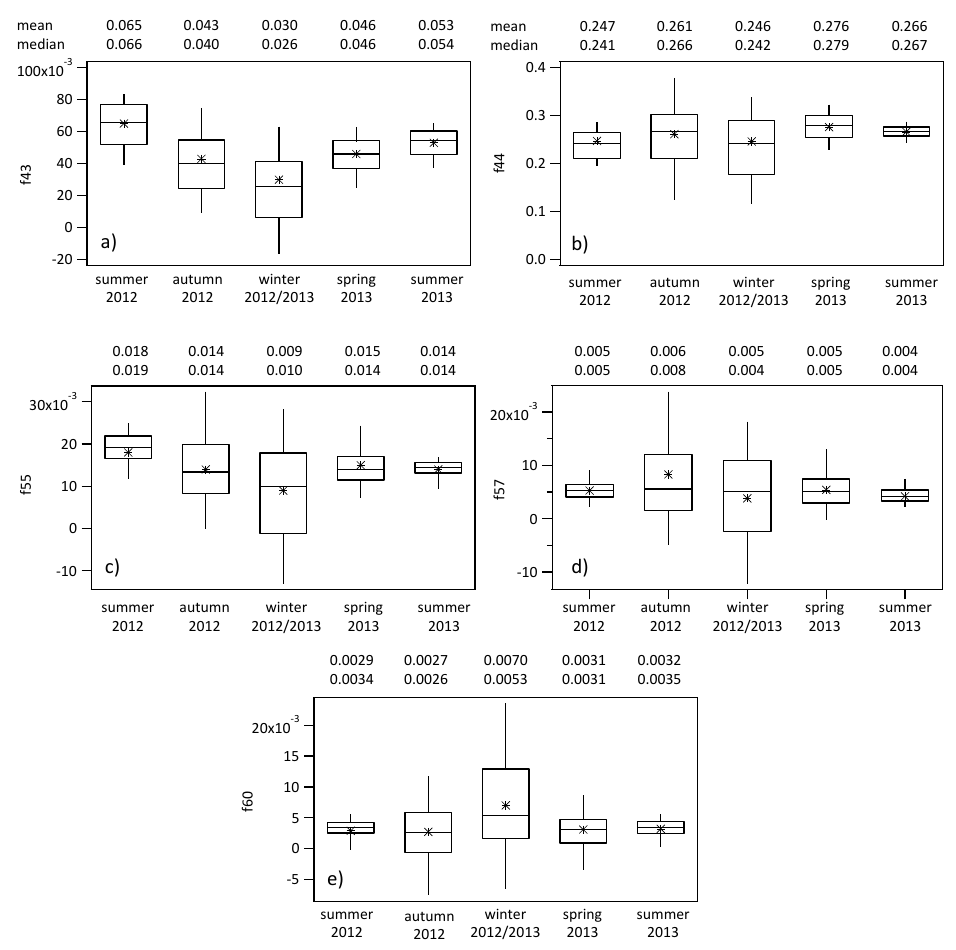
Figure 7. Seasonal variation of fractions of total OA for different mass-to-charge ratios: (a) f 43 , (b) f 44 , (c) f 55 , (d) f 60 . Mean (star) and median (horizontal bar) values are given above each boxplot. The IQR is shown as a box and the 10th to 90th percentile range as whiskers. The contribution of local primary organic aerosols was subtracted from the mass spectra before calculation of the fractions. It is noted, that the increased width of the distribution in winter and autumn is due to smaller signal-to-noise ratio during these